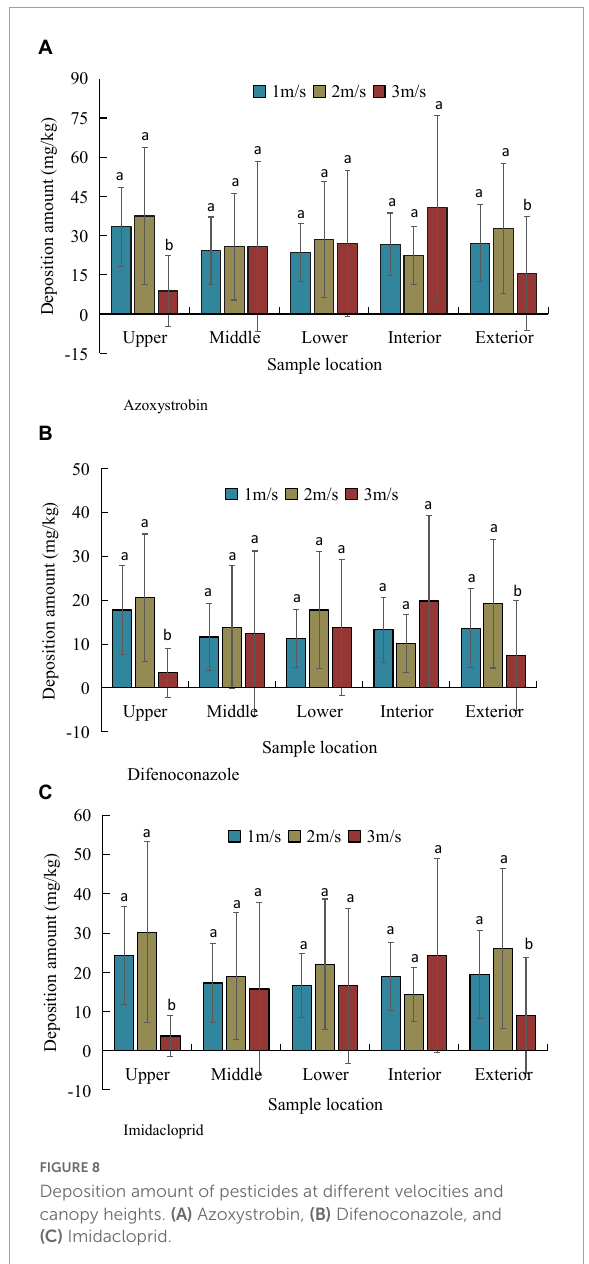
FIGURE8 Deposition amount of pesticides at different velocities and canopy heights. (A) Azoxystrobin, (B) Difenoconazole, and (C)